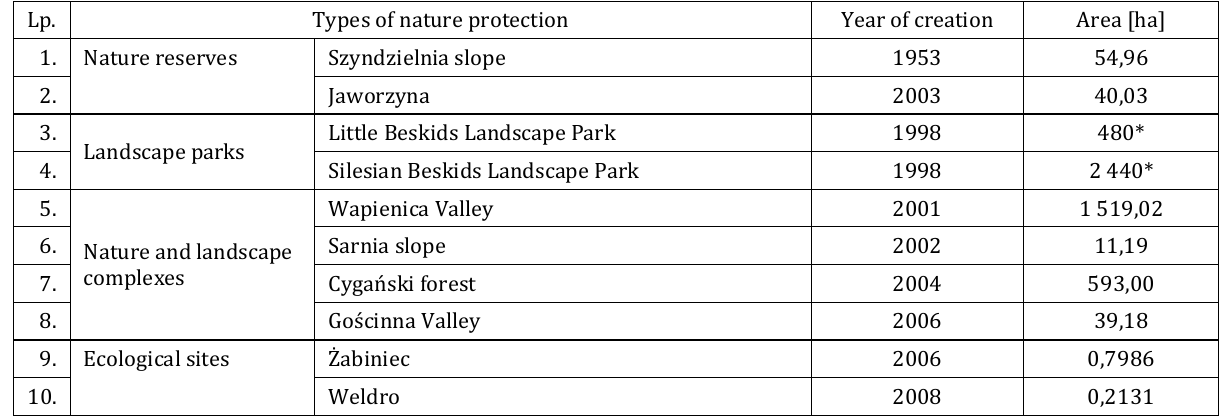
Table 1. List of the types of nature protection in